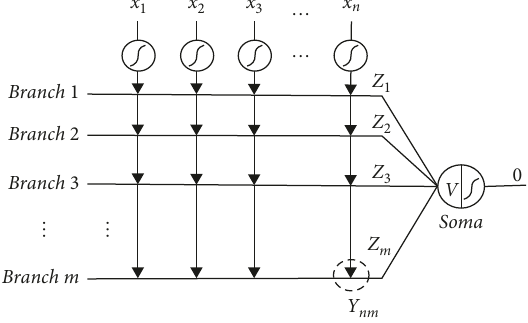
Figure 1: Structure of the dendritic neuron model.